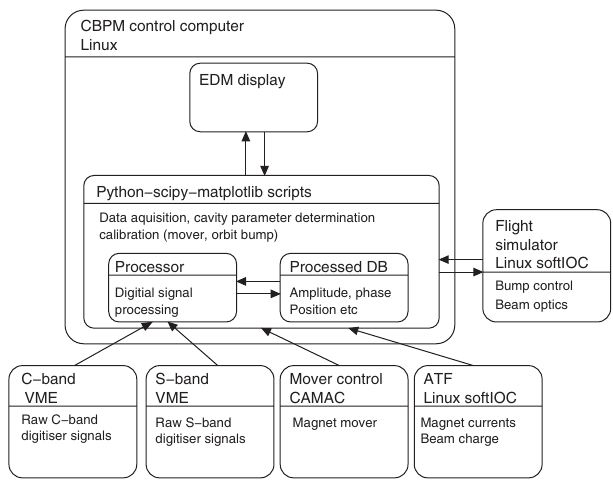
FIG. 13. BPM software and controls